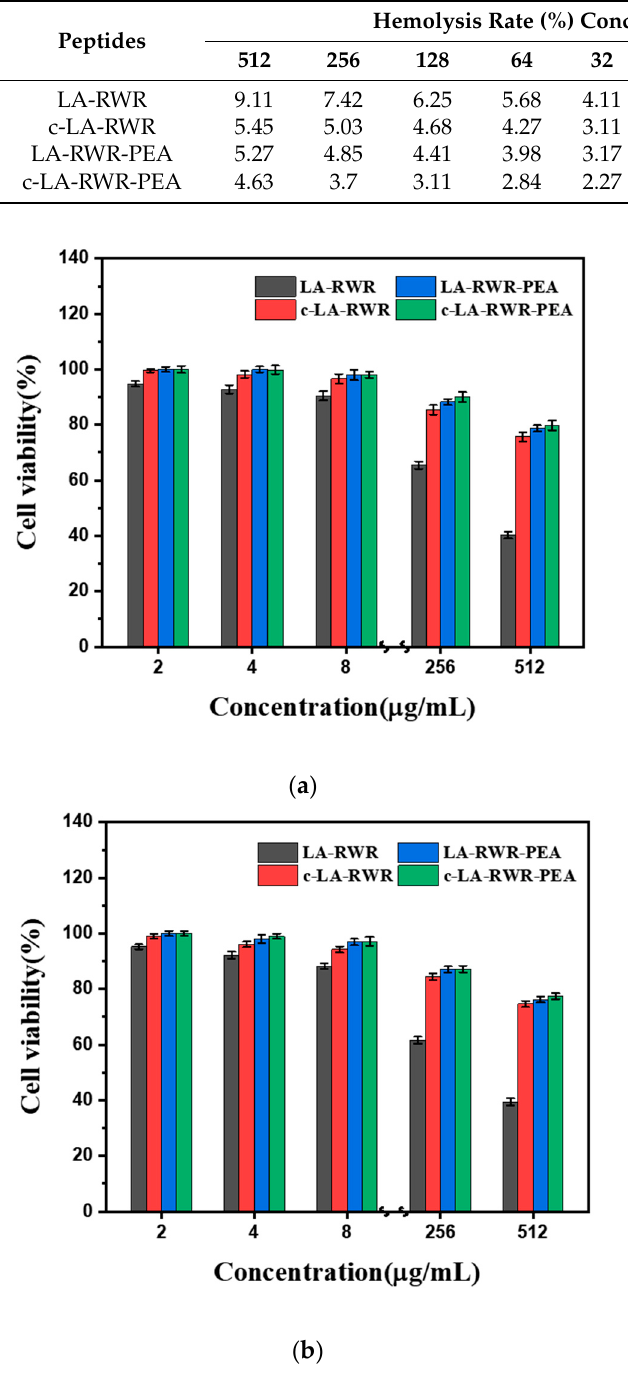
Figure 8. Cell viability of ( a ) L929 cells and ( b ) BHK ‐ 21 cells treated with LA ‐ RWR, c ‐ LA ‐ RWR na ‐